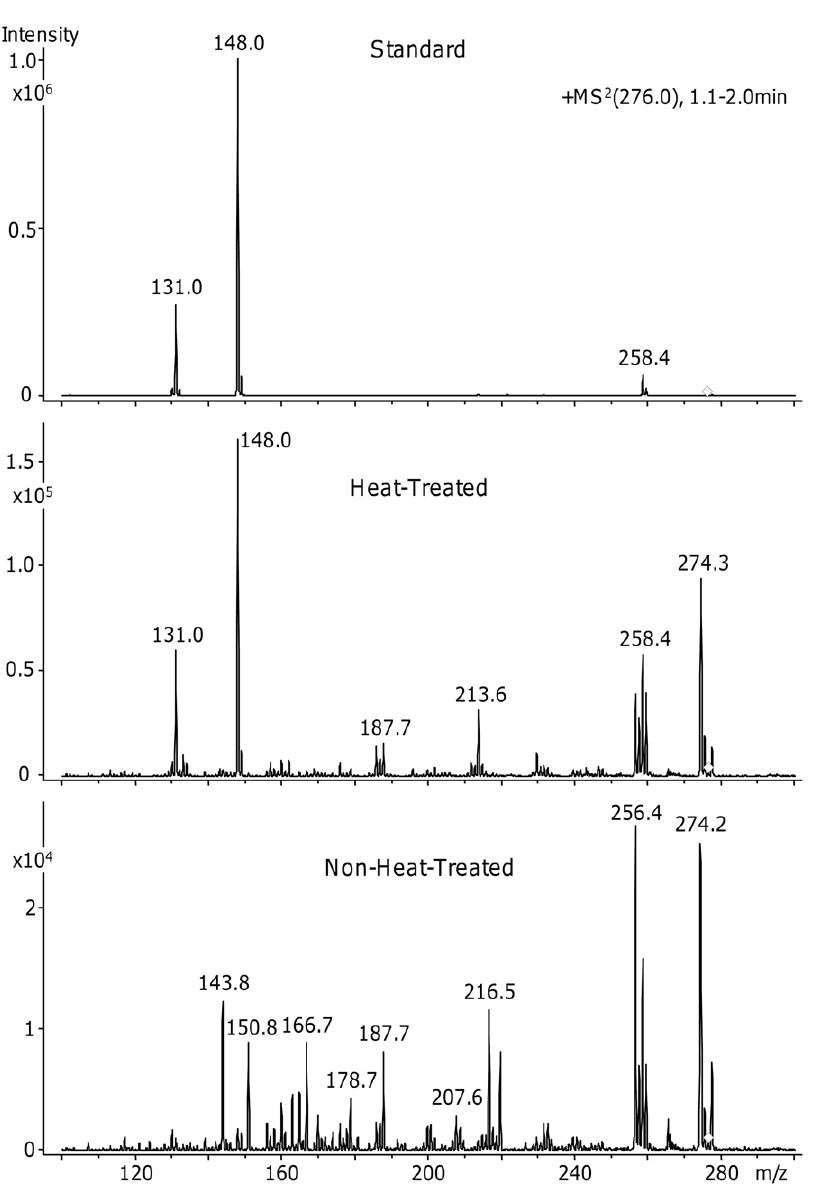
Figure 9. LC-MS/MS detection of the isopeptide crosslink, e -( c -glutamyl)-lysine. The panels show tandem mass spectra at 1 to 2 minutes monitoring m/z =276 for the e -( c -glutamyl)-lysine standard, for heat-treated, enzyme-digested honeybee silk sponge and for non-heat-treated, enzyme-digested honeybee silk.